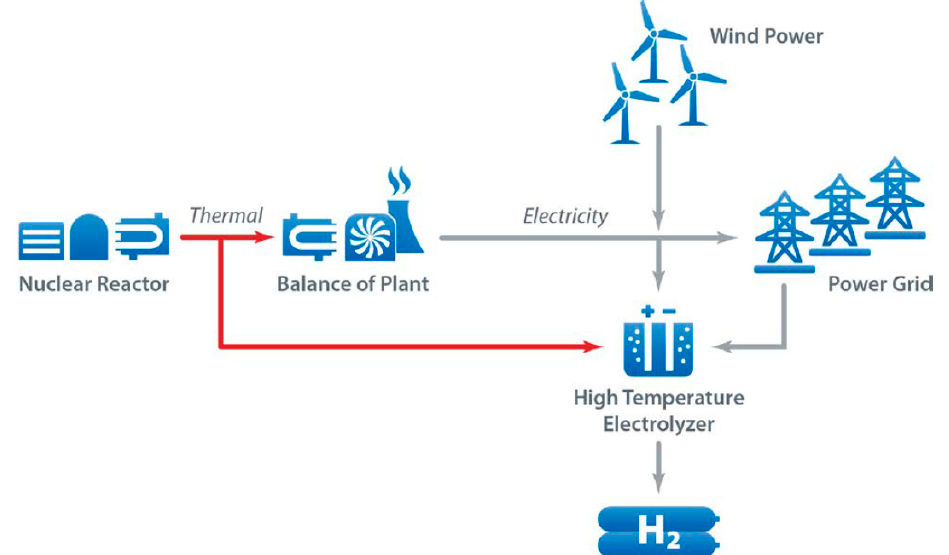
Figure 3. Energy sources for pink, green, and yellow hydrogen production [12].